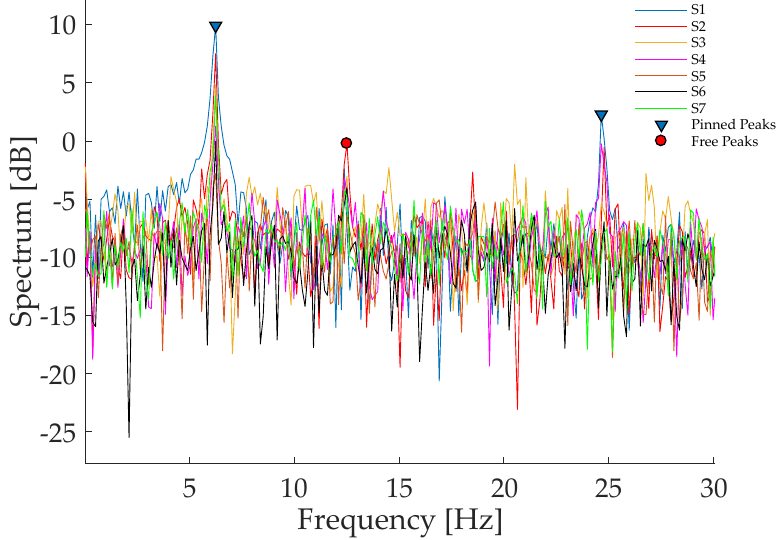
Figure 10. Comparison of spectral density characteristics of tilt signals estimated via FFT elaboration by nodes located at different